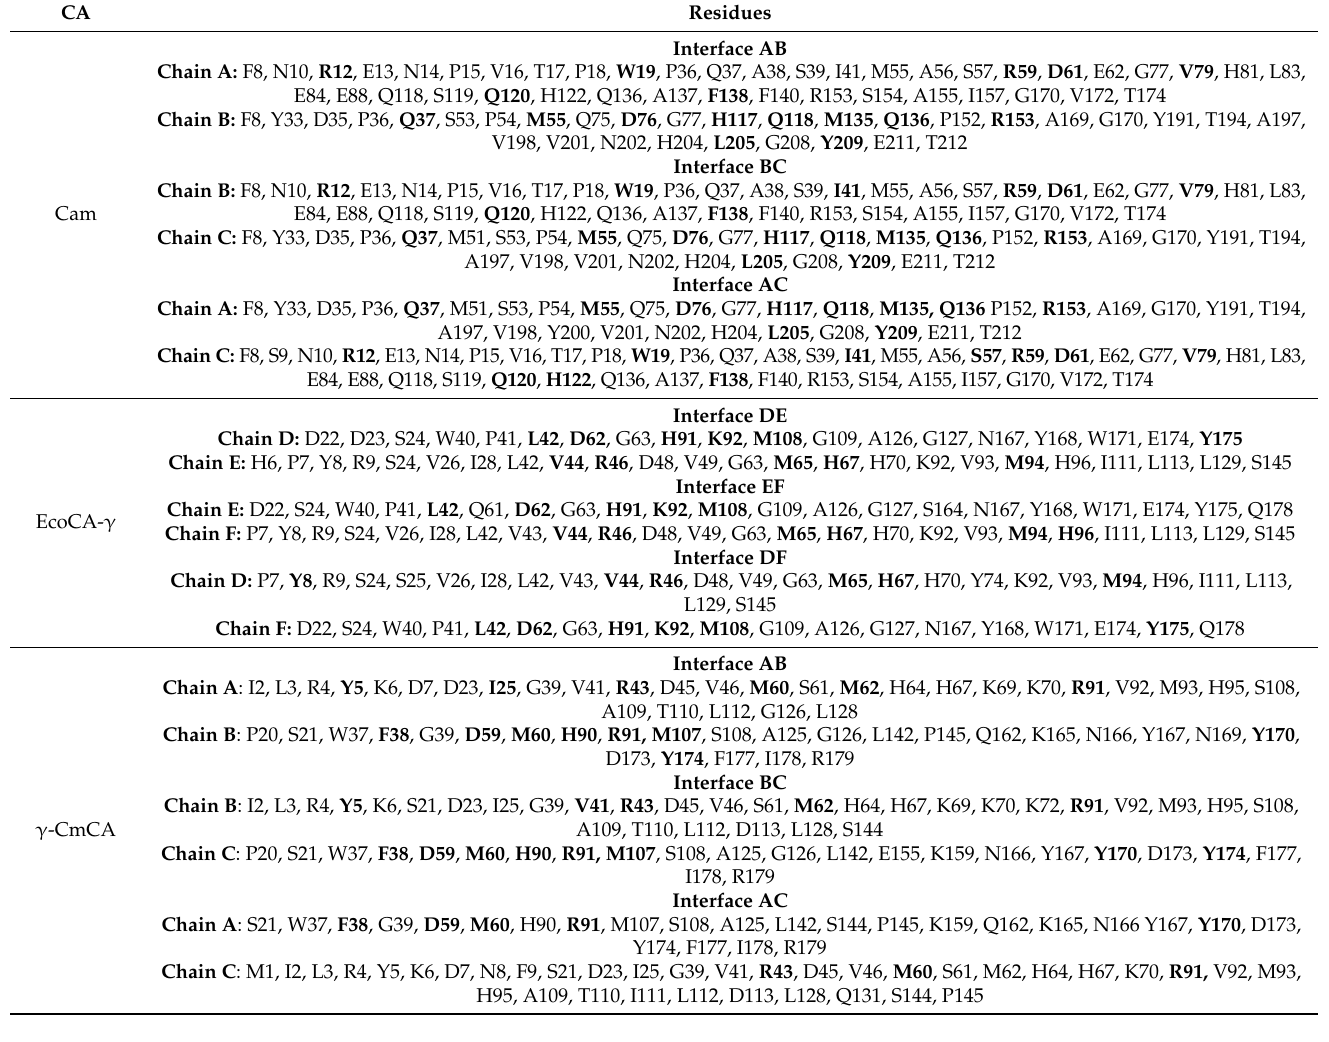
Table 2. Residues common to three out of five programs identified as participating in interface formation. Hotspot residues are in